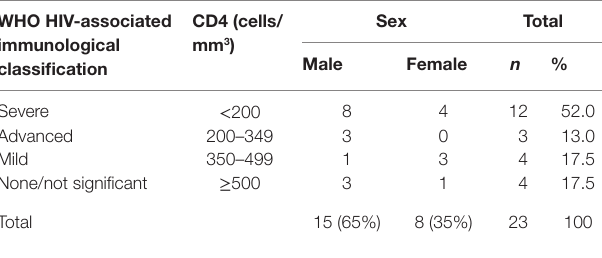
TaBle 1 | Demographics of hiV cases by World health Organization (WhO) immunological